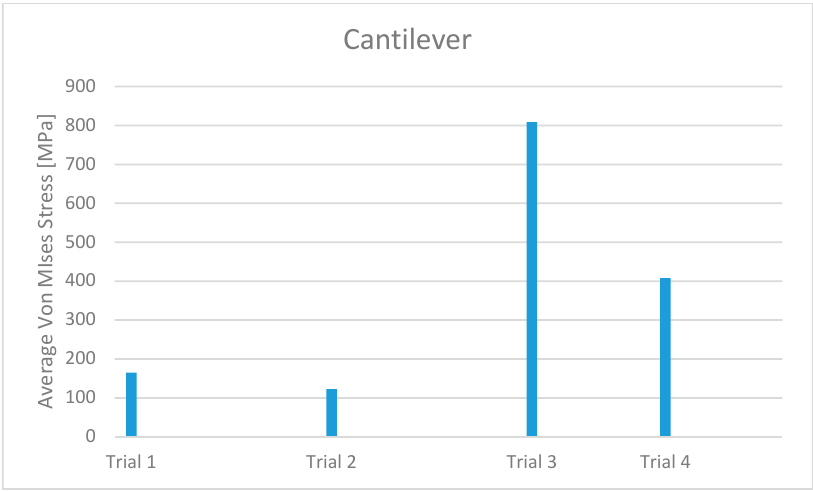
Figure 13. Passant screw stress maximum value for each trial and for the different fixtures. Materials 2018 , 11 , x FOR PEER REVIEW